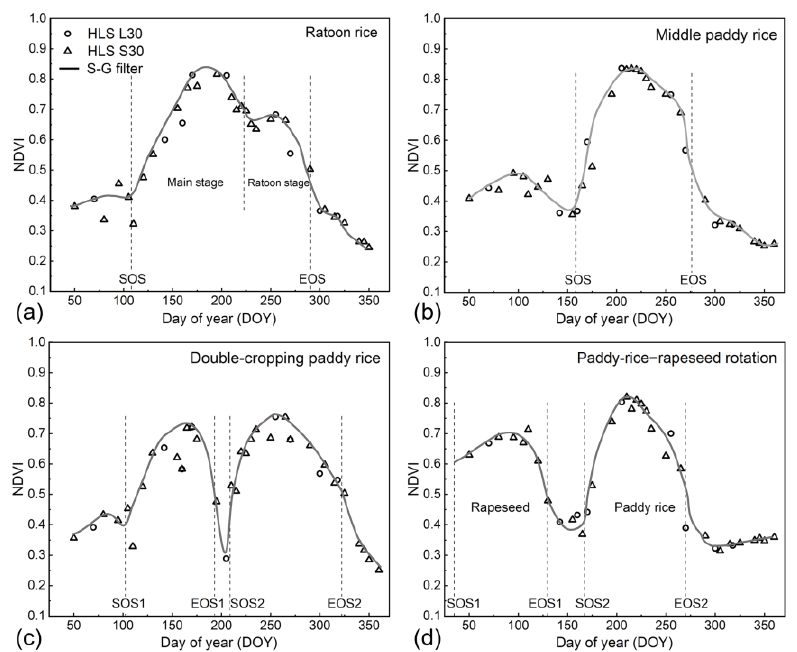
Figure 5. The NDVI temporal trajectory with the detected SOS and EOS dates after S-G filtering for ( a ) ratoon rice, ( b ) middle paddy rice, ( c ) double-cropping paddy rice, and ( d ) paddy-rice – rapeseed rotation.